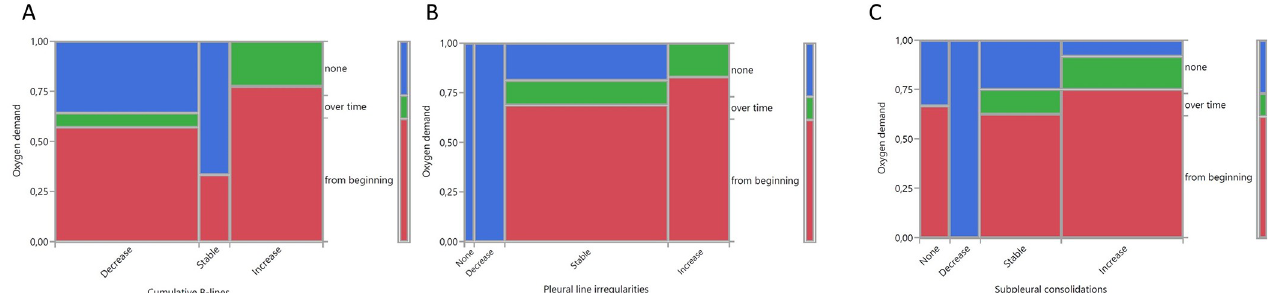
Fig 9. Association between change in cumulative B-lines (A), pleural line irregularities (B), subpleural consolidations (C) and oxygen demand.